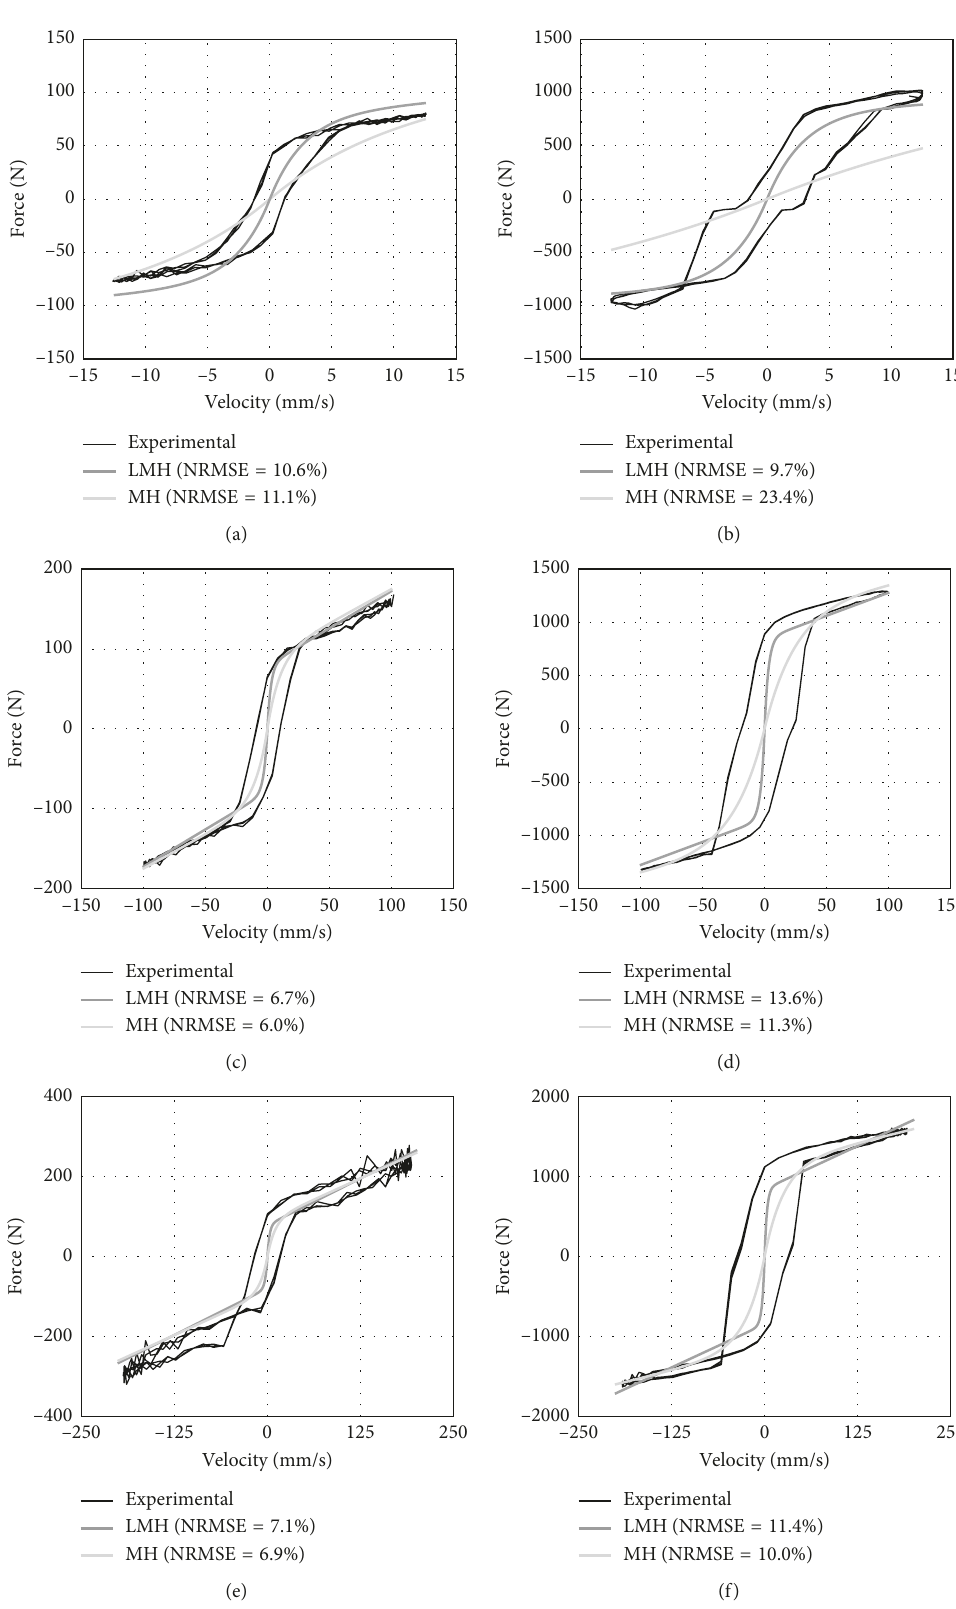
1 A; (e) high velocity without intensity; (f) (cid:31)